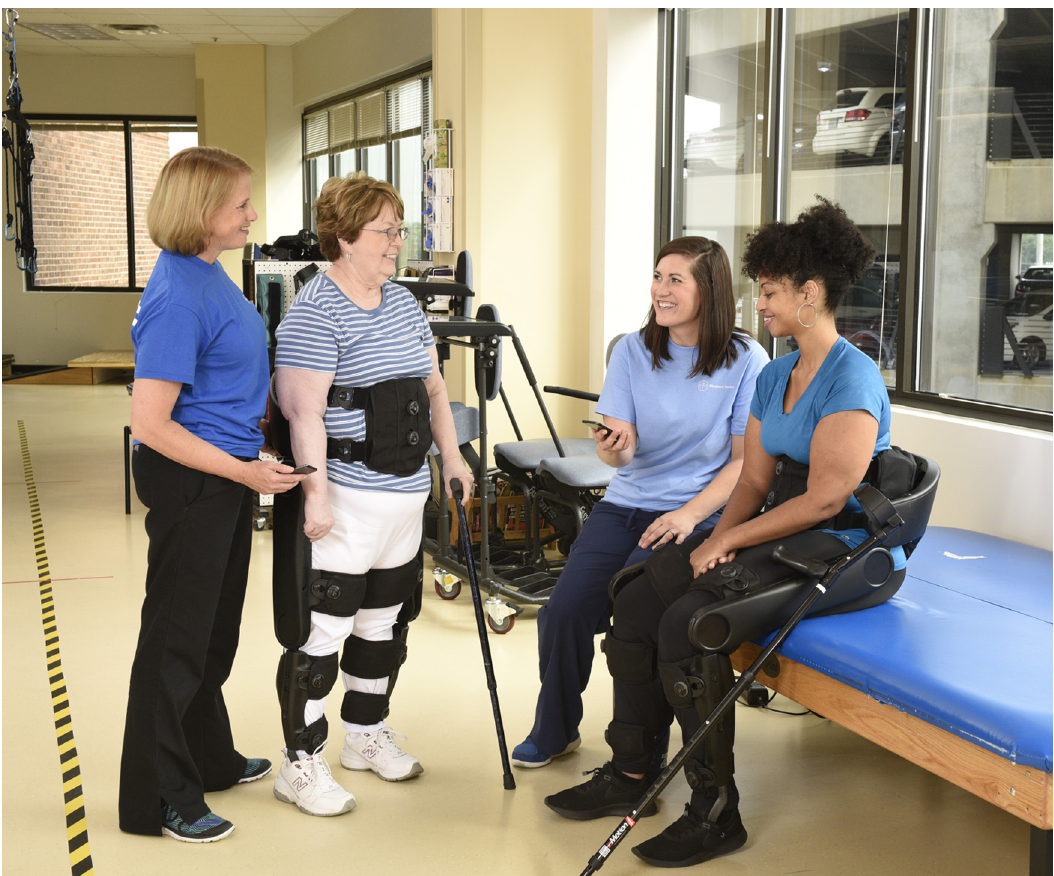
Figure 1: Indego therapy; photo courtesy of Parker Hanni fi n Corporation, USA.